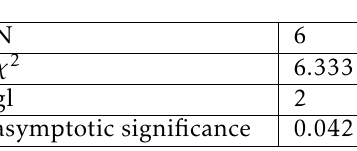
Table 2. Friedman’s statistical test results